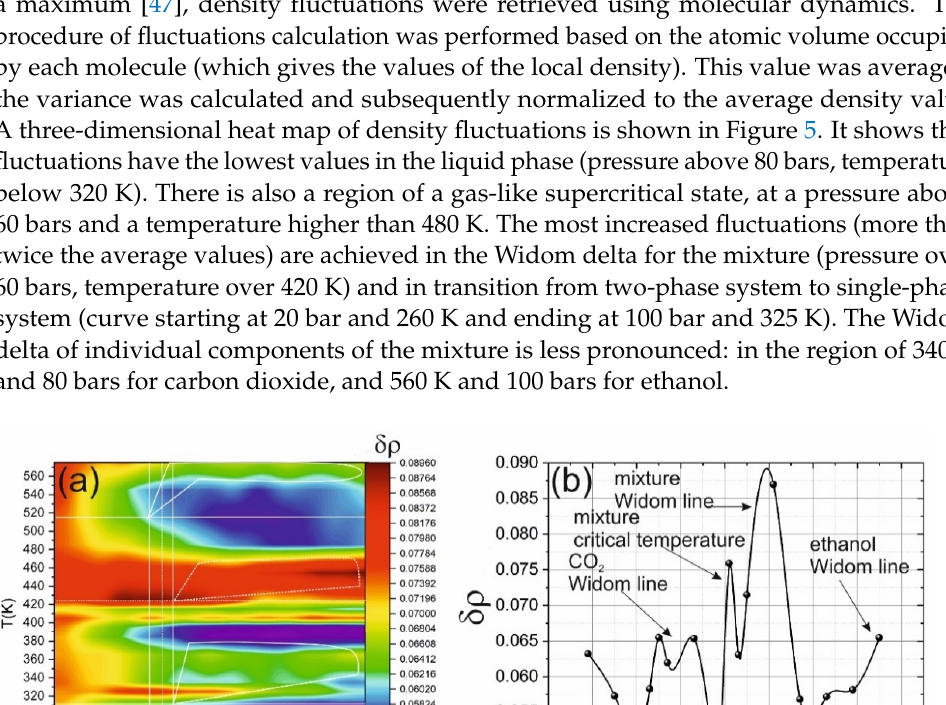
Figure 5. ( a ) Heat map of the density fluctuations δρ / δ p dependence on pressure and temperature. Solid lines show the critical temperature and pressure of carbon dioxide and ethanol; dashed lines show mixture parameters. The highlighted areas correspond to the Widom delta (solid lines for carbon dioxide and dashed lines for mixtures). ( b ) The dependence of density fluctuations δρ on temperature from Figure 5a under pressure of 161 bar.